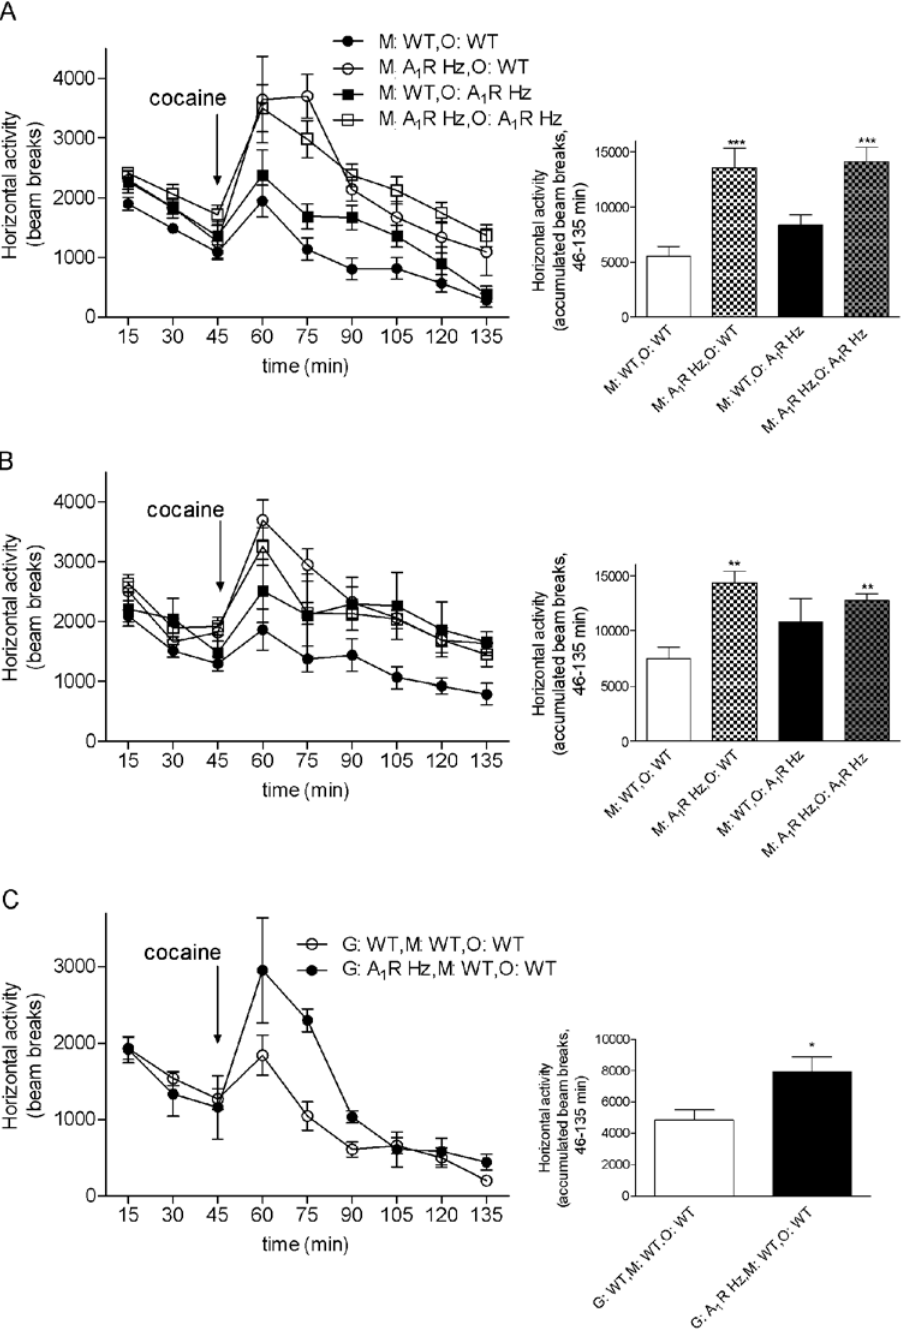
Figure 6. Effect of mother ’ s genotype on cocaine responce. A 1 R Hz mice are similar to mice exposed to perinatal caffeine in locomotor response to cocaine and this response seems to be dependent on mother’s genotype, not offspring’s (A,B). Closed circle represents WT mice born to a WT mother (M:WT,O:WT, males n=11, females n=12), open circle WT are mice born to an A 1 R Hz mother (M:WT,O:A 1 R Hz, males n=6, females n=6), closed square stand for A 1 R Hz mice born to a WT mother (M:A 1 R Hz,O:WT, males n=6, females n=3) and open square A 1 R Hz mice born to a A 1 R Hz mother (M:A 1 R Hz,O: A 1 R Hz, males n=12, females n=10). Mice were habituated to the open-field arena for 45 min before administration of cocaine (10 mg/kg, i.p.), immediately followed by a 90-min test session. Arrow indicates time of injection of cocaine or vehicle. Results are shown